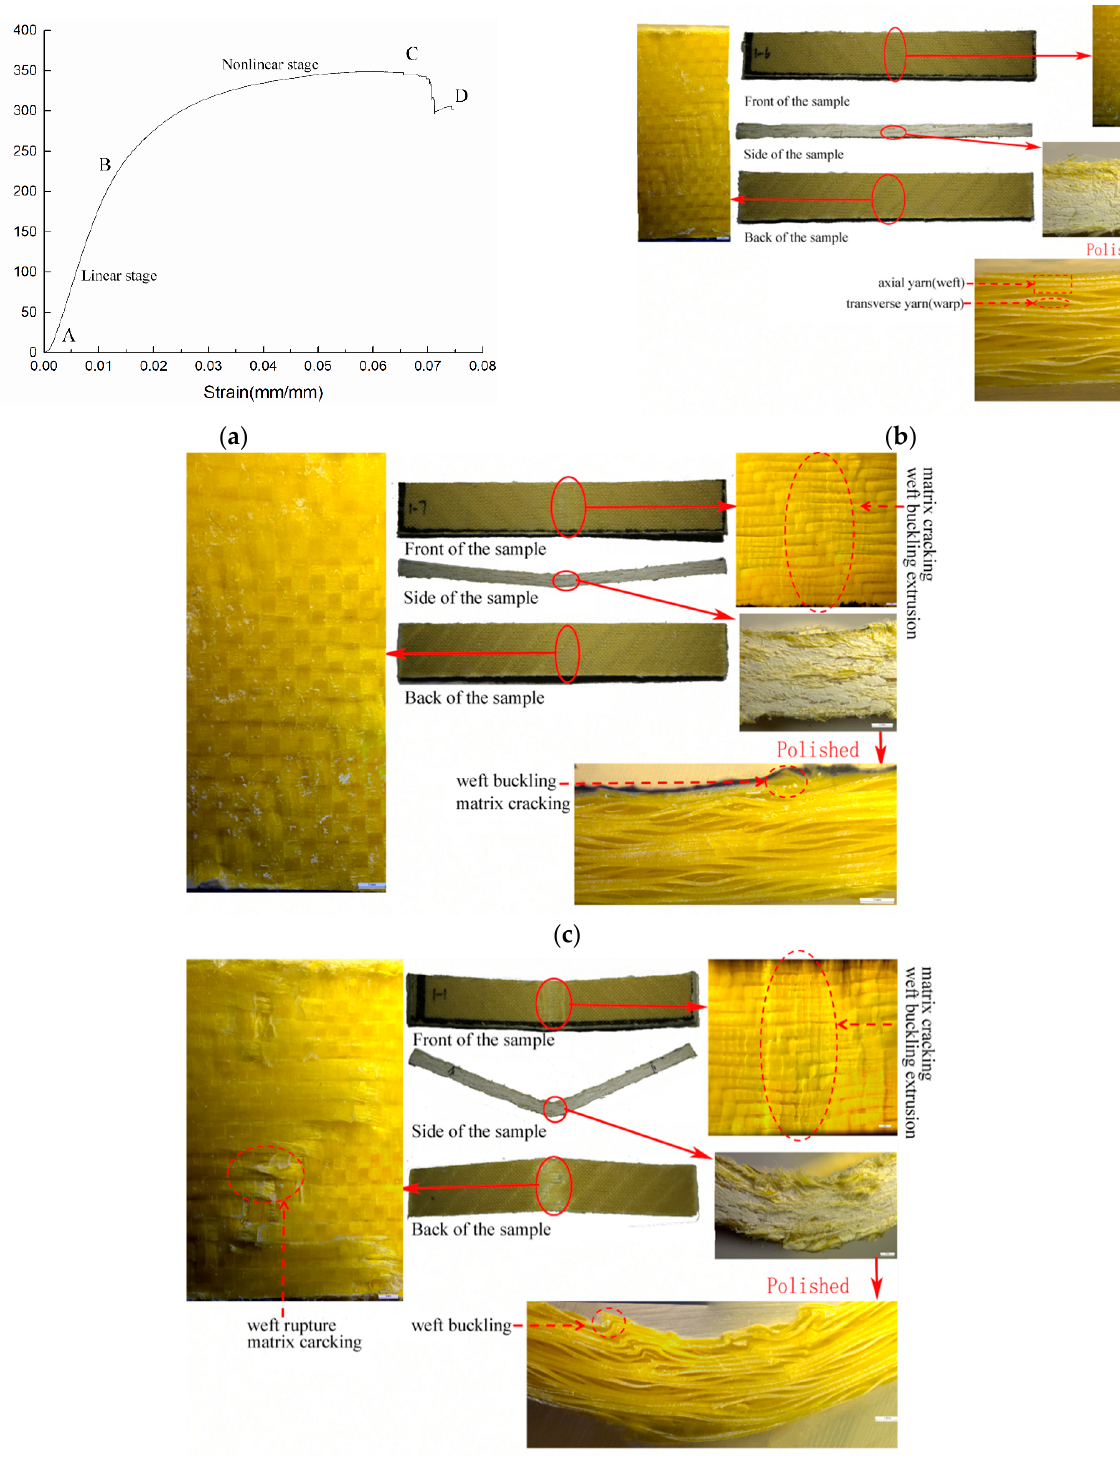
Figure 5. The bending response of 3DDAI Kevlar/EP armor material when loaded along the weft direction. ( a ) The bending stress-strain curve. ( b ) The topography of the material at point B. ( c ) The topography of the material at point C. ( d ) The topography of the material at point D.